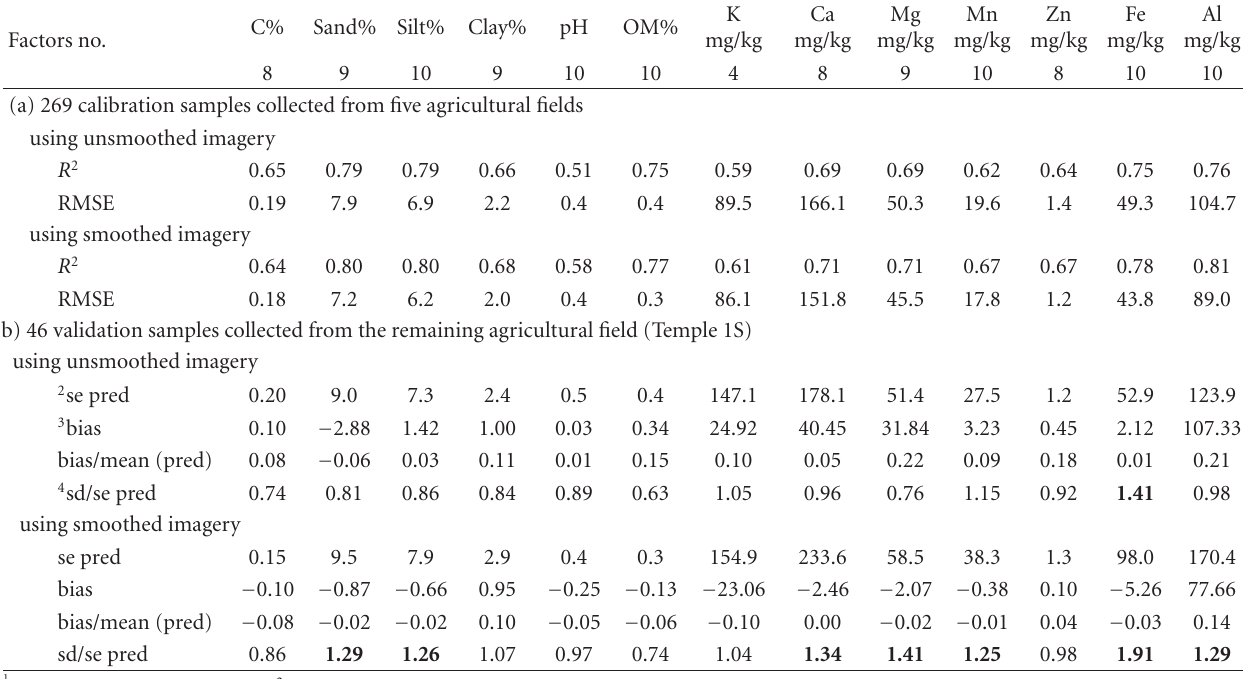
Table 3: Partial least squares (PLS) model accuracy in predicting soil analyte concentrations 1 for (a) the 269 calibration samples using repeated leave-one-out cross validation and (b) 46 validation samples from the field (Temple 1S) that had been left apart from the calibration. Results were derived using a first derivative gap 2 math pretreatment, using spectra derived from unsmoothed imagery (2.5m 2 pixel size) or from spatially smoothed imagery to which a 3 × 3 low pass filter had been applied. See Section 2 for analyte descriptions. Units refer to analyte residual mean squared error (RMSE) values. Bold indicates sd/sepred > 1.20. Factors